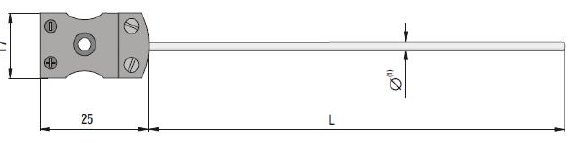
Fig. 6. A scheme of a K-type thermocouple, Czaki Thermo- Product, Poland